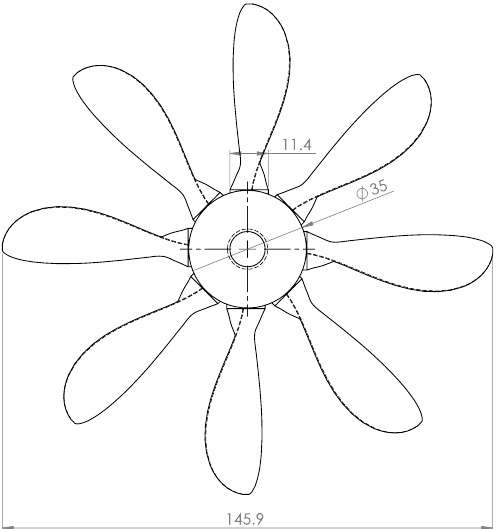
Figure 5. Planform of the propeller model for wind tunnel testings [37]. Units in